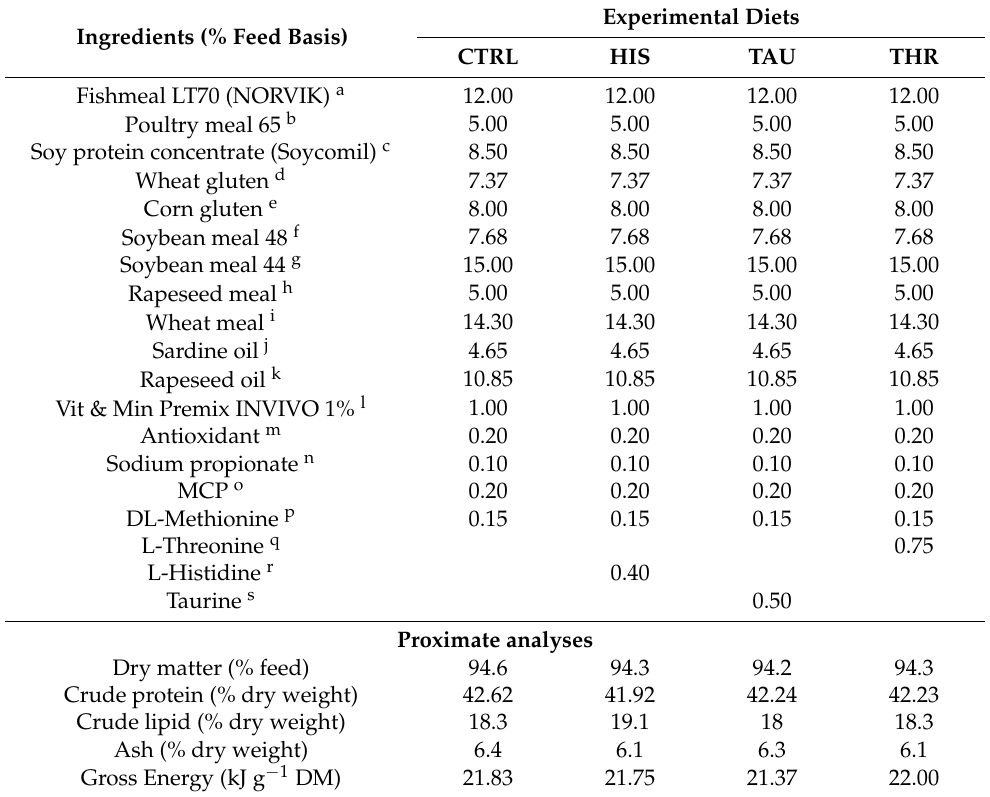
Table 1. Ingredients of the experimental